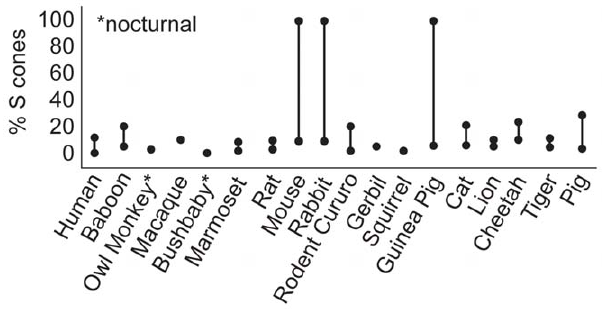
Figure 10. Dominance of L cones over S cones across species. Measured S cone proportion is shown for a variety of animals [2,9,59,82–90]. For some animals, two measurements at different locations on the retina are shown. Large variation in L cone proportion indicates dorso-ventral asymmetries, like those discussed in [90].